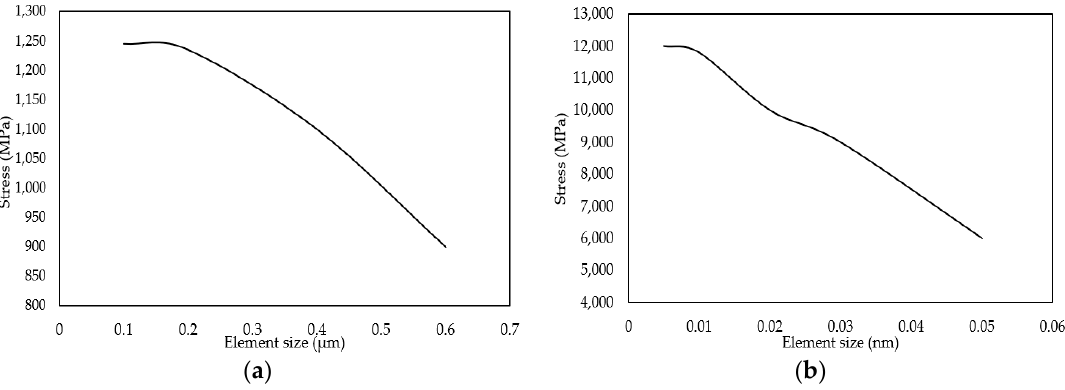
Figure 2. Convergence plots of FE model: ( a ) No GO layers on Al particles; ( b ) Al particles covered with GO layer.